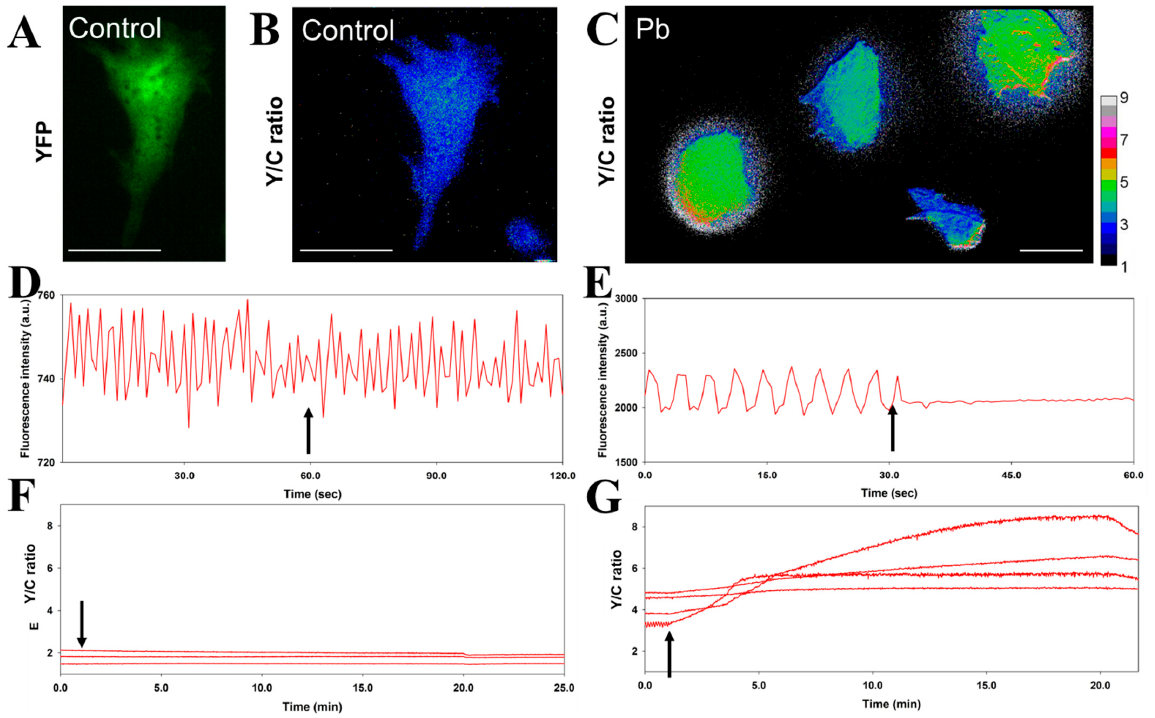
Figure 2. The simultaneous recording of the physiological activity and entry of Pb into iPSC-derived cardiomyocytes. ( A – C ), The acceptor (YFP) image ( A ) and the FRET Y/C ratio images ( B , C ) of cells expressing Met-lead 1.44 M1 were acquired in control buffer ( A , B ) or after Pb treatment (50 μ M; ( C )). The color bar for B and C represents Y/C ratio values from 1 to 9. The scale bars are 40 μ m. ( D , E ), Within the 25-min recordings, the time-lapse fluctuation of fluorescence signals in the tested cells revealed the beating activity (control in ( D ); Pb in ( E )). ( F , G ), Simultaneously, intracellular Pb sensing (Y/C ratio increase) could be observed in control ( F ) and Pb ( G ) treatments. Buffer without (Control) or with Pb (Pb) was introduced at the time points indicated by